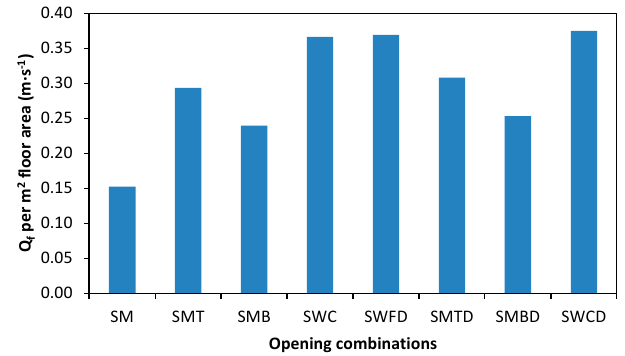
Figure 12. Airflow rate per unit floor area in different opening combinations.